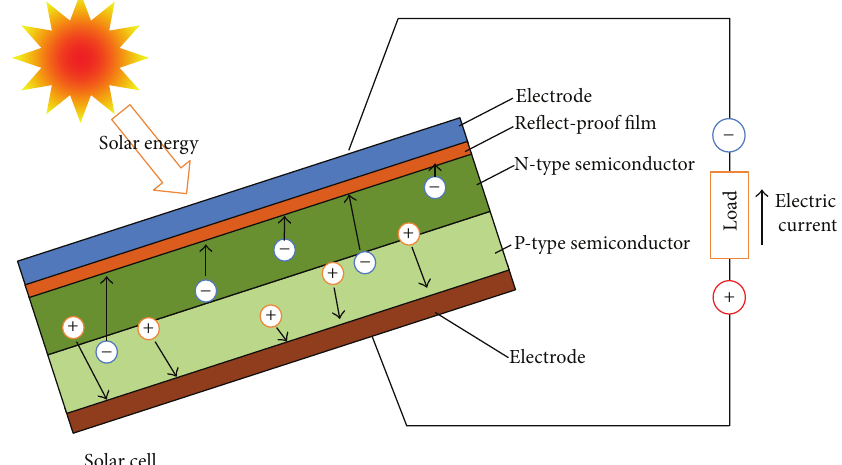
Figure 1: Schematic operating principle of a PV solar cell (adapted from